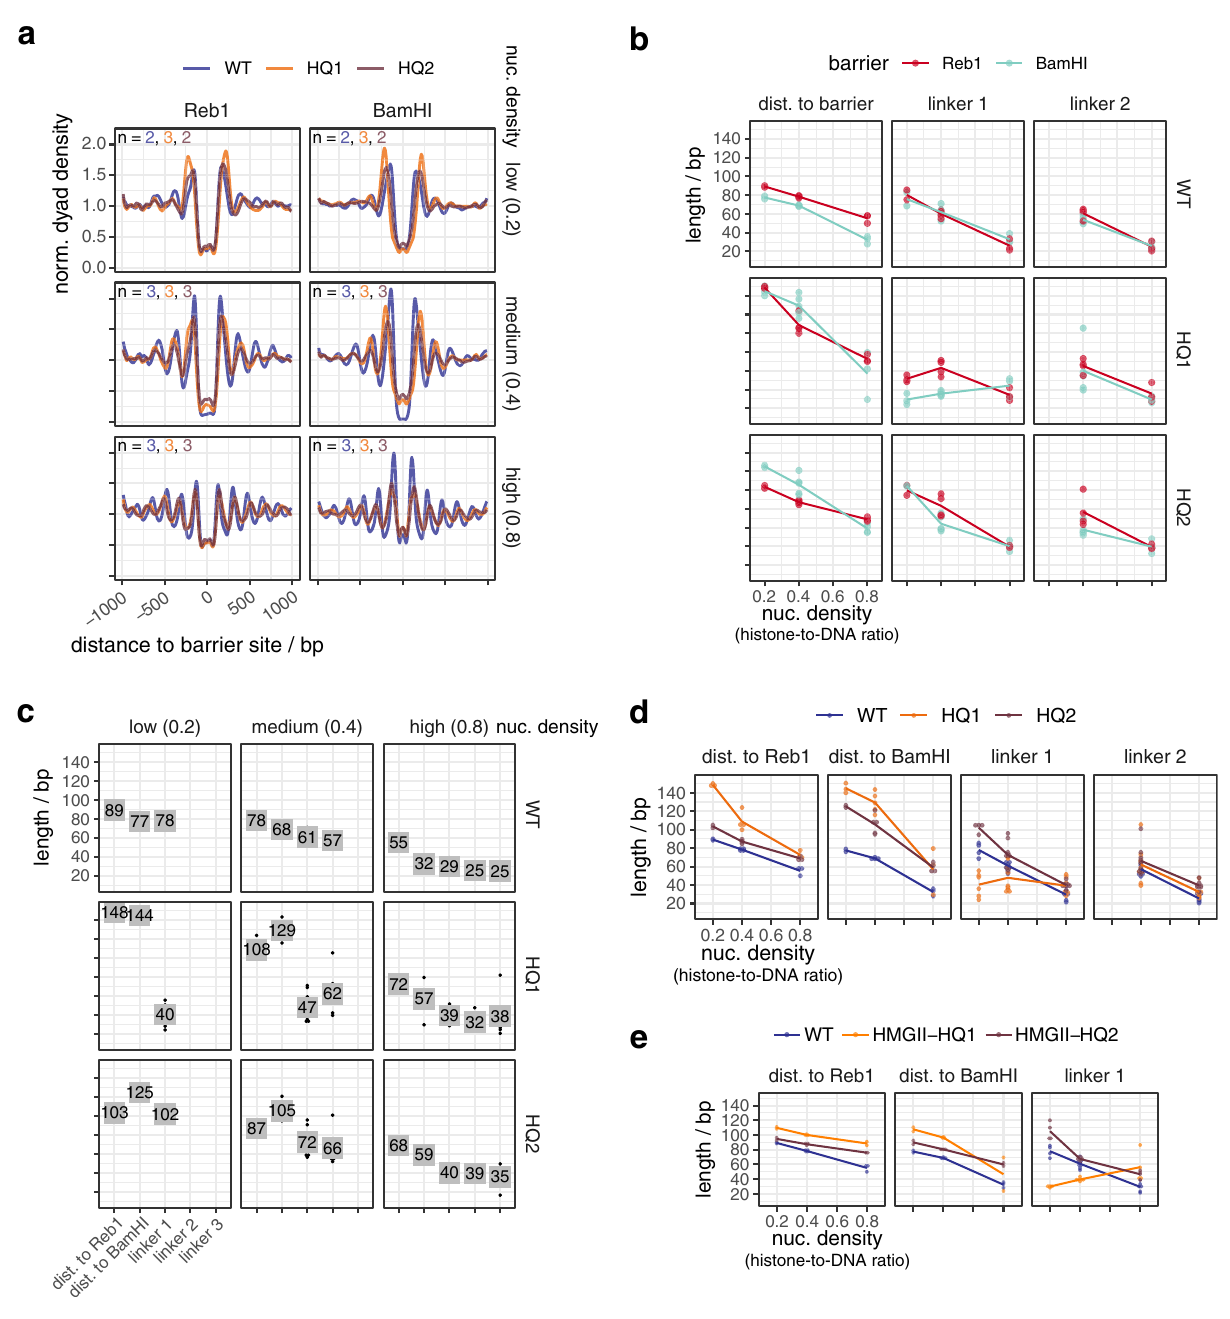
Fig. 5 Mutations in the INO80 Arp8 module affect the generation of array features. a Composite plots of merged replicates as in Fig. 2a but for the indicated WT and mutant INO80 complexes and nucleosome densities. Composite plots of individual replicates in Supplementary Fig. 5a. b – d As Fig. 2c – e, respectively, but comparing indicated WT and mutant INO80 complexes. e As Fig. 2e, but for the indicated WT and mutant INO80